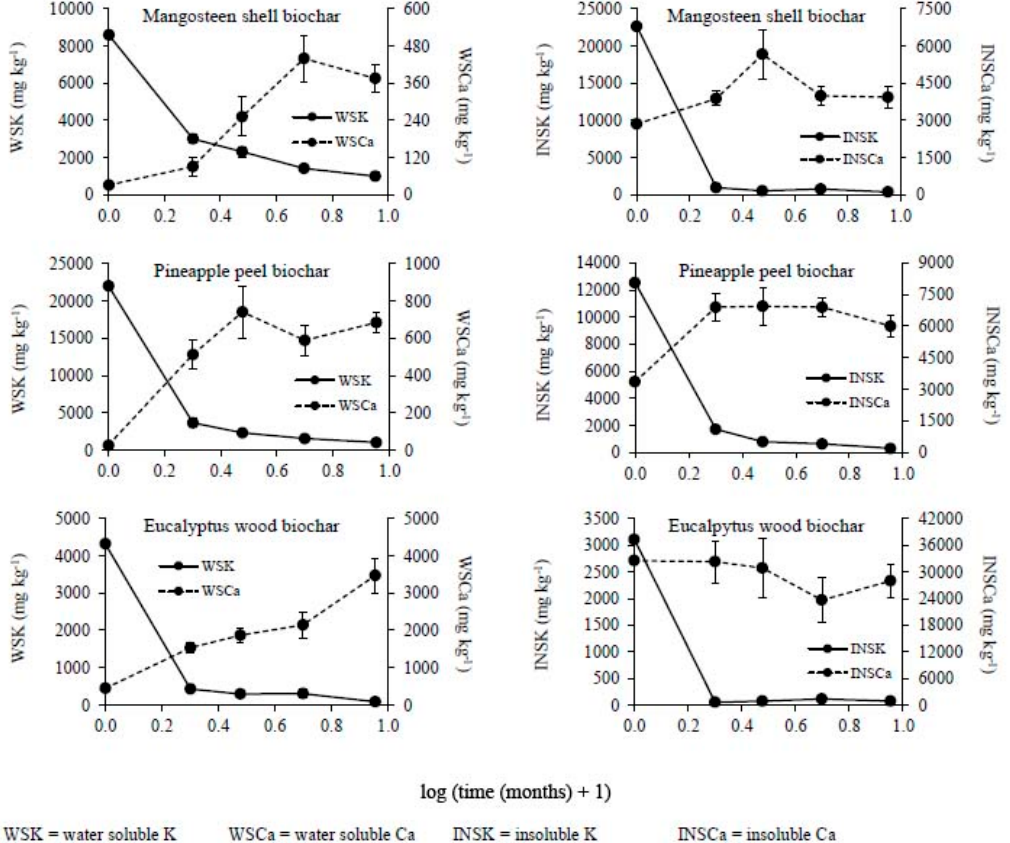
Figure 2. Plots of mean value and standard deviation for water soluble and insoluble K and Ca versus time in soil for three biochars recovered from soil at zero, 1, 2, 4, and 8 months. Mean values and SD are for nine soils.